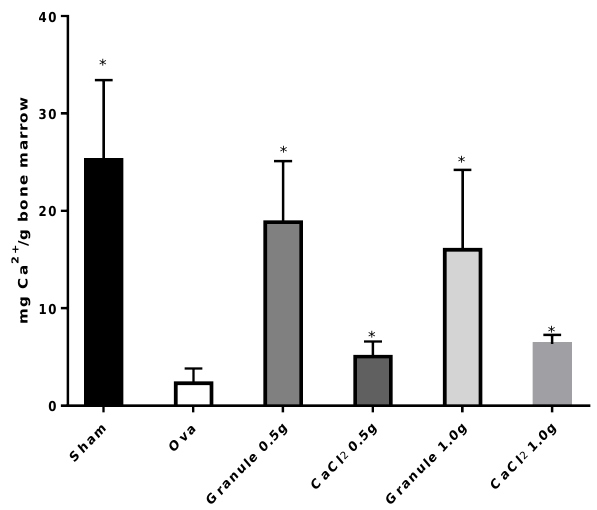
Figure 5. Ca 2 + amount (mg) per g of bone marrow in rat femur. * p < 0.05 versus Ova Group. Figure 5. Ca 2+ amount (mg) per g of bone marrow in rat femur. * p < 0.05 versus Ova Group.